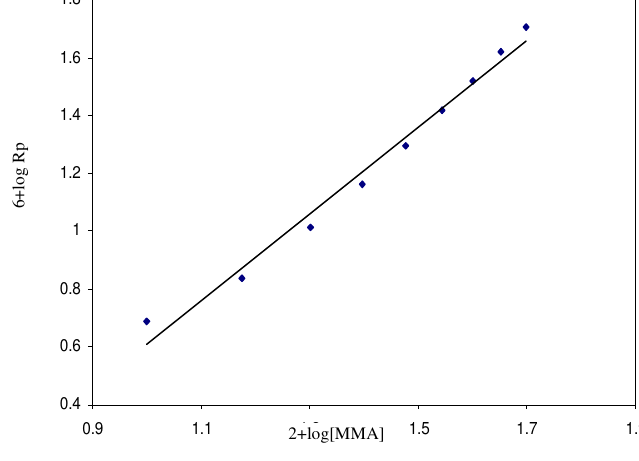
Figure 1. Plot log [MMA] vs. log Rp